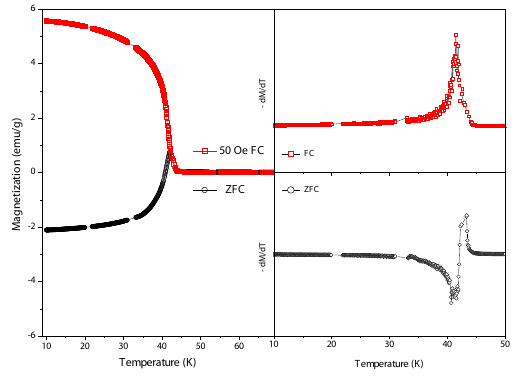
Figure 4. Zero-field-cooled (ZFC) and field-cooled (FC) magnetization curves for sonochemically synthesized Mn at 50 Oe external magnetic field, and –dM/dT curves with respect to T for both FC and ZFC.